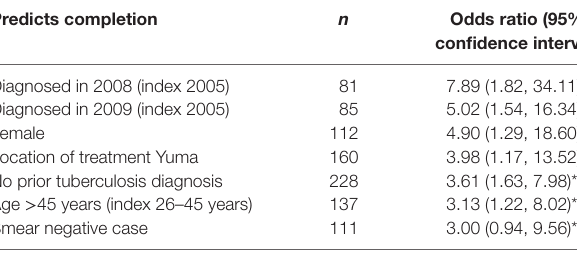
TaBle 5 | Model predicting treatment completion: all cases ( R 2 = 0.2116, n =